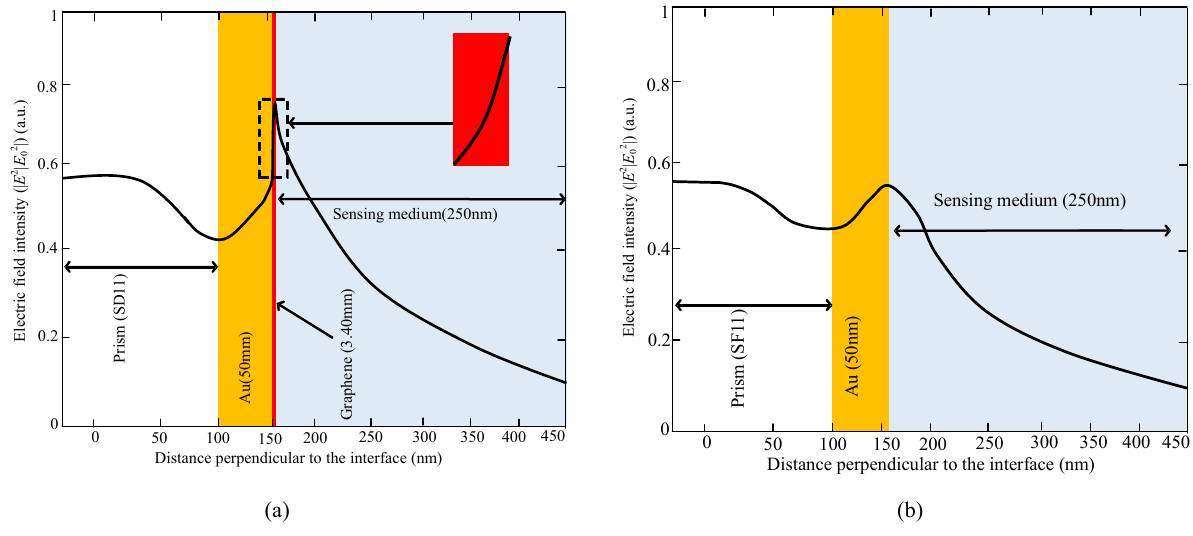
Fig.6 Normalized electric field intensity (a) with ( L =10) graphene layers and (b) without graphene